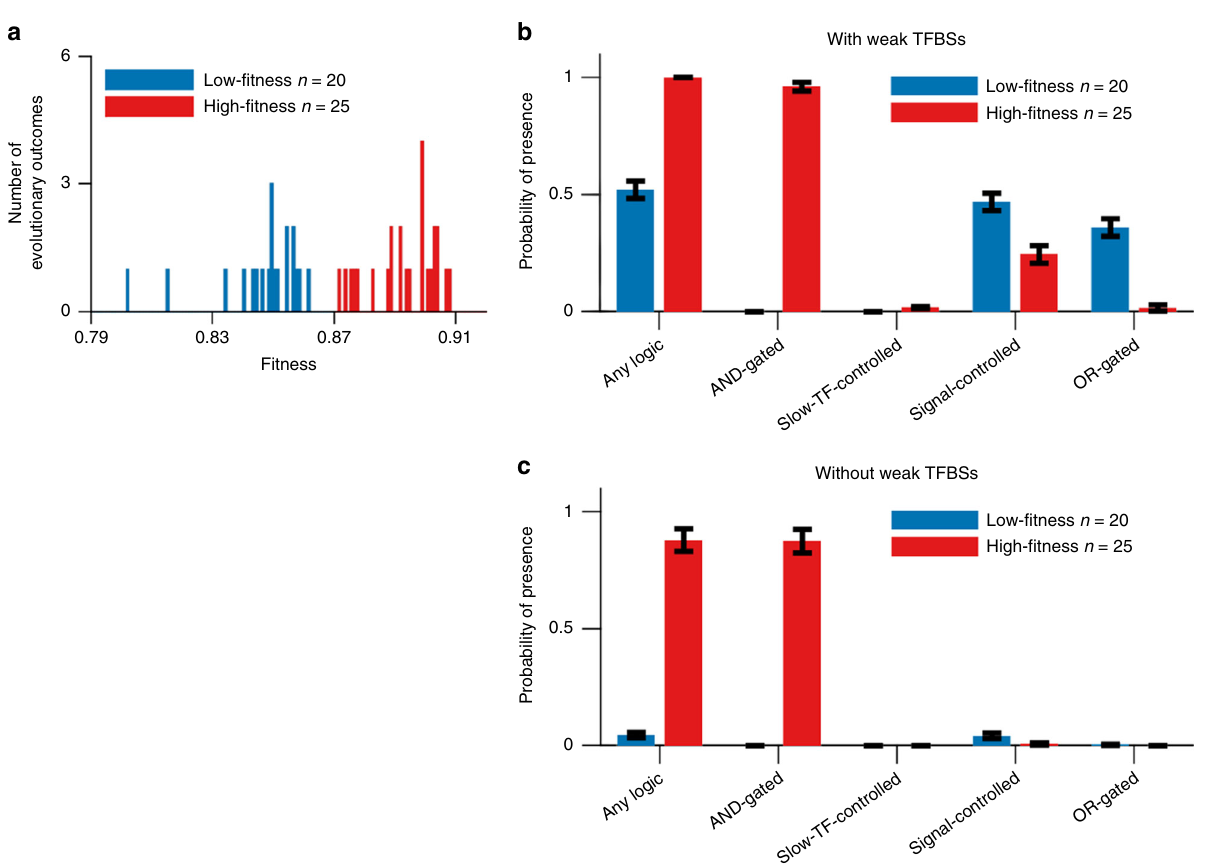
Fig. 4 AND-gated C1-FFLs are associated with a successful response to selection. a Distribution of fi tness outcomes across replicate simulations, calculated as the average fi tness over the last 10,000 steps of the evolutionary simulation. We divide genotypes into a low- fi tness group (blue) and a high- fi tness group (red) using as a threshold an observed gap in the distribution. b High- fi tness replicates are characterized by the presence of an AND-gated C1-FFL. “ Any logic ” counts the presence of any of the seven subtypes shown in Fig. 2b. Because one TRN can contain multiple C1-FFLs of different subtypes, each of which are scored, the sum of the occurrences of all seven subtypes will generally be more than “ Any logic ” . See Supplementary Methods for details on the calculation of the y axis. c The overrepresentation of AND-gated C1-FFLs becomes even more pronounced relative to alternative logic-gating when weak (two-mismatch) TFBSs are excluded while scoring motifs. Data are shown as mean ± s.e.m. of the occurrence over replicate evolution simulations